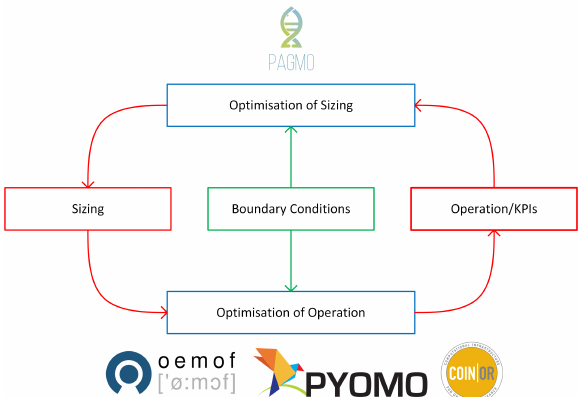
Figure 3. Flow chart of the energy system optimal sizing loop. The interaction of the various existing software solutions and their interfaces, as well as the necessary consideration of the boundary conditions, is to be seen particularly. All this is implemented in a holistic Python based